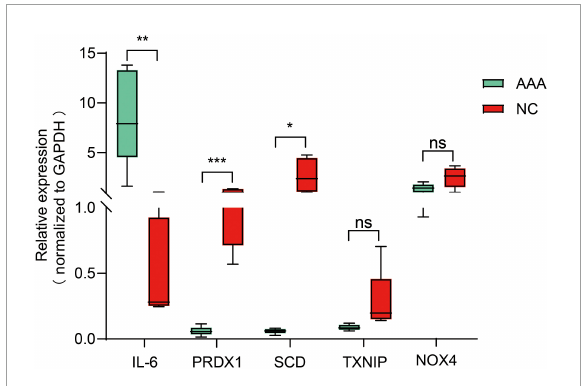
FIGURE7 Verification of the expression of the first five hub candidate genes in clinical samples: IL-6, PRDX1, SCD, TXNIP, and NOX4. P-values were calculated using the Student’s t -test. * P < 0.05; ** P < 0.01; *** P < 0.001. IL-6, interleukin-6; PRDX1, peroxiredoxin 1; SCD, stearoyl-CoA desaturase; TXNIP, thioredoxin interacting protein; NOX4, NADPH oxidase 4; ns,